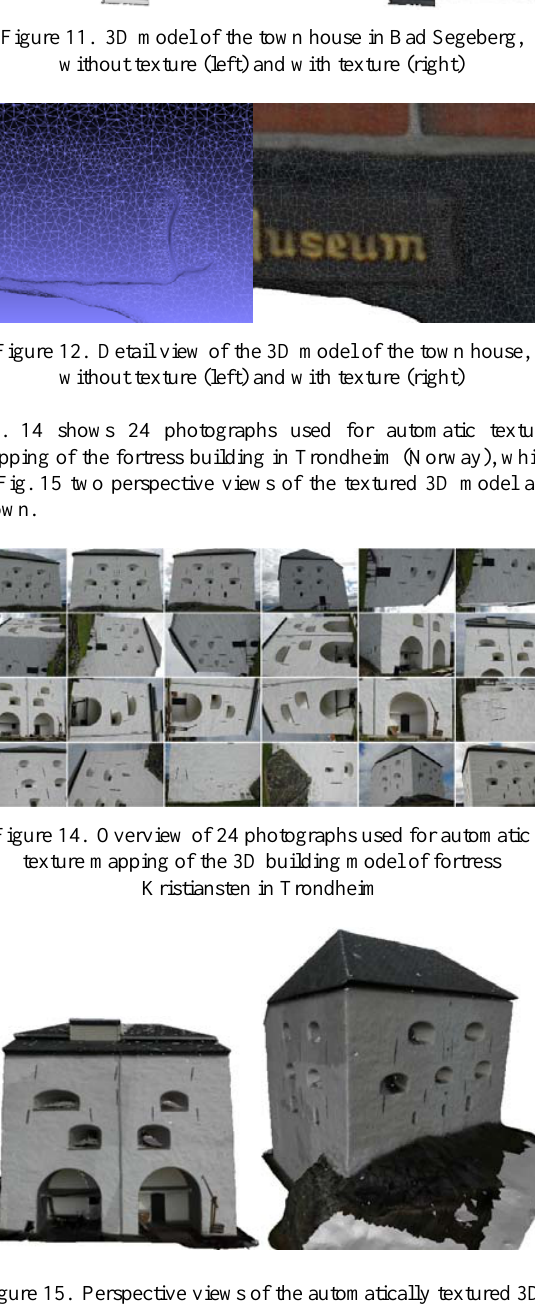
Figure 15. Perspective views of the automatically textured